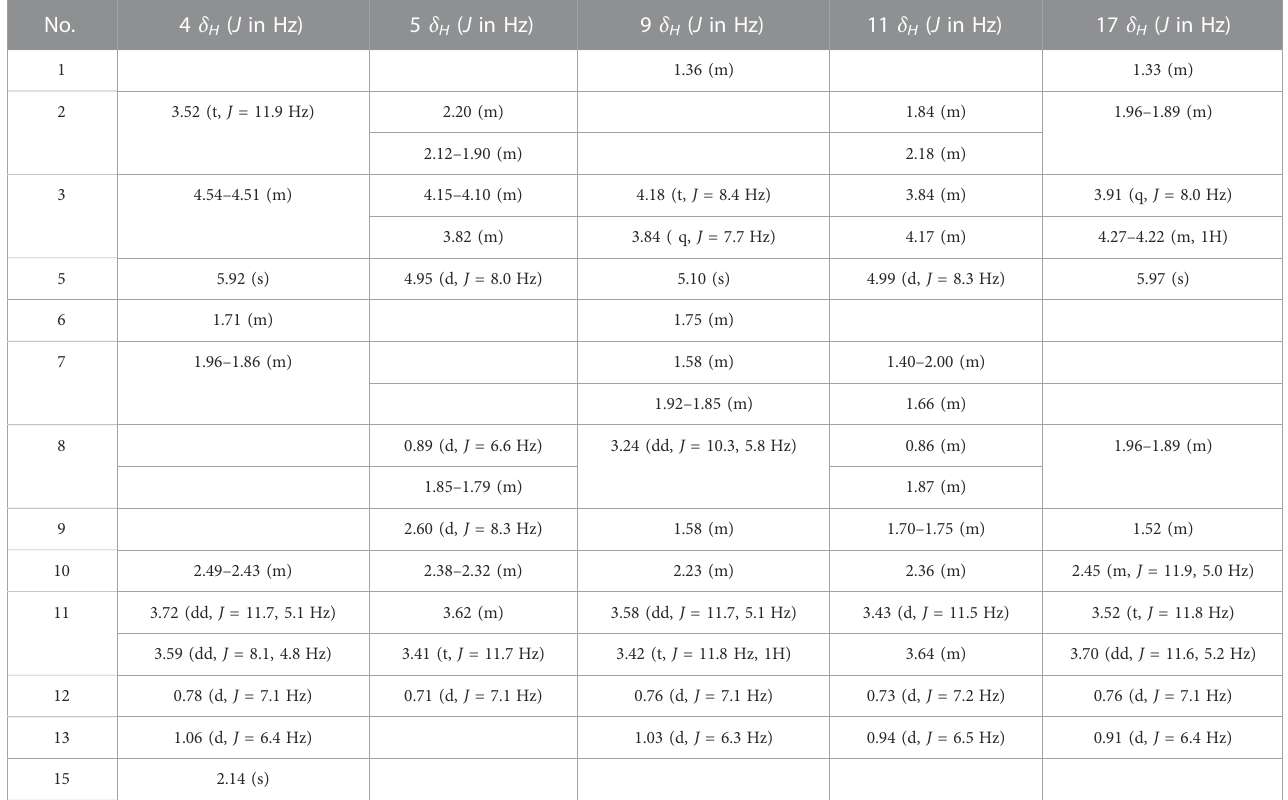
TABLE 4 1 H-NMR spectral data ( δ ) for compounds 4 , 5 , 9 , 11 , and 17 .